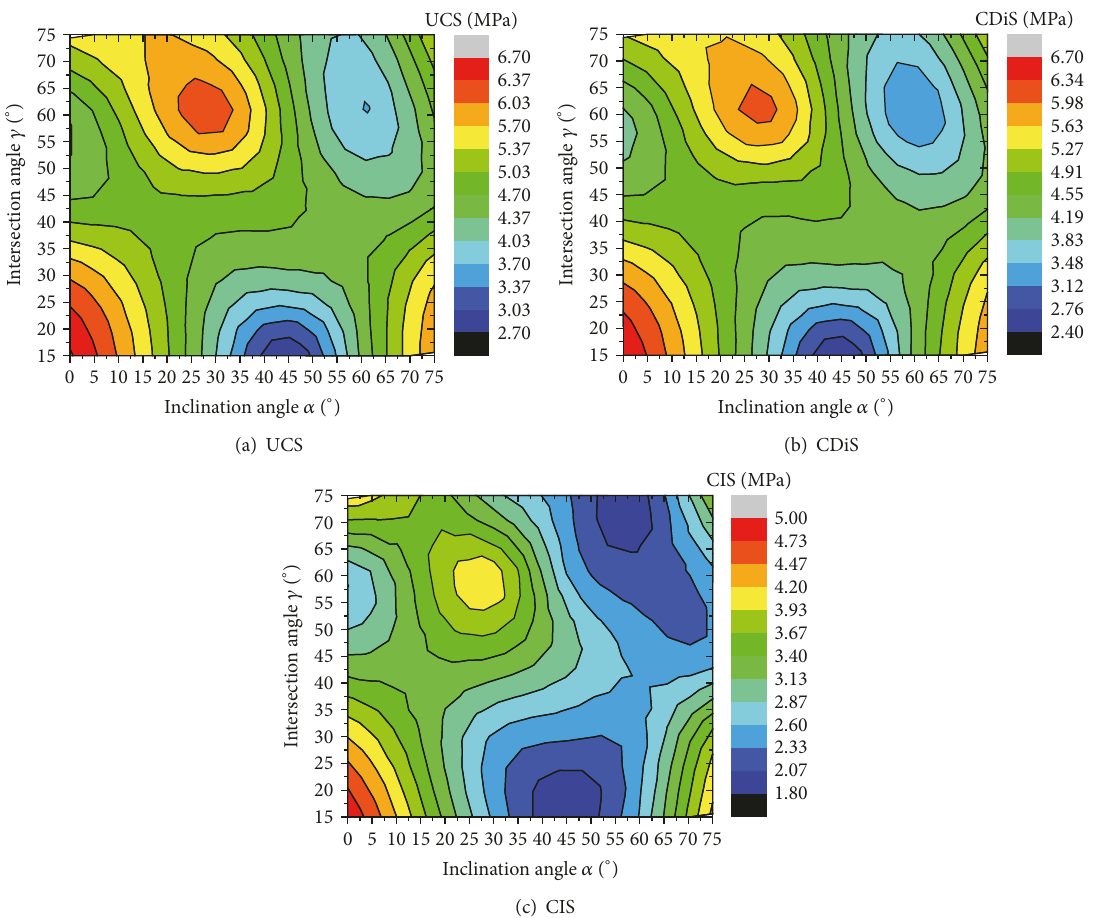
Figure 9: Effect of joint inclination on the characteristic stresses: (a) for UCS; (b) for CDiS; (c) for